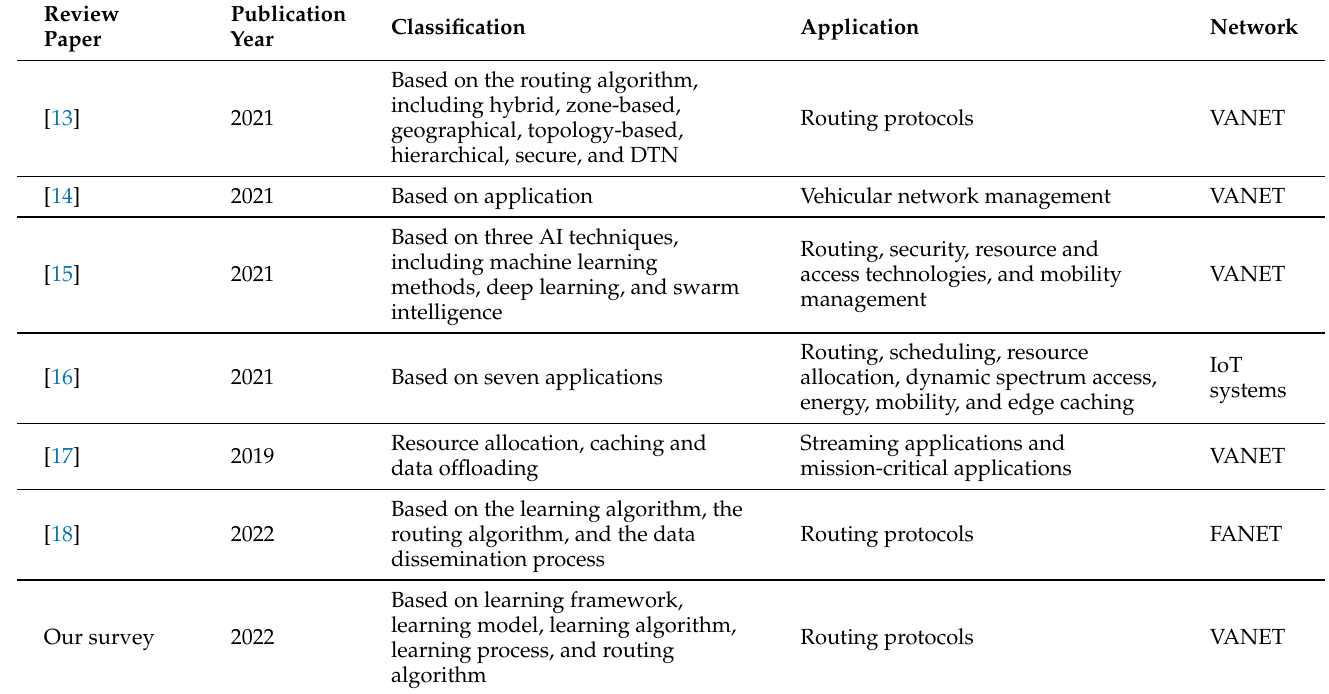
Table 2. Some review articles related to RL applications in